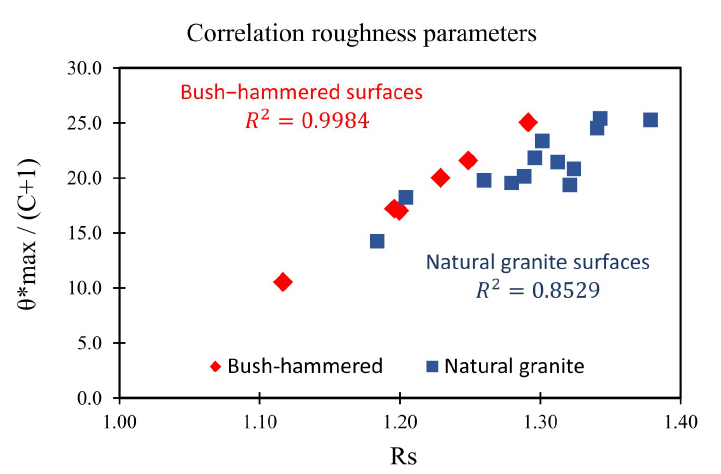
Figure 3. Roughness: bush-hammered and natural granite